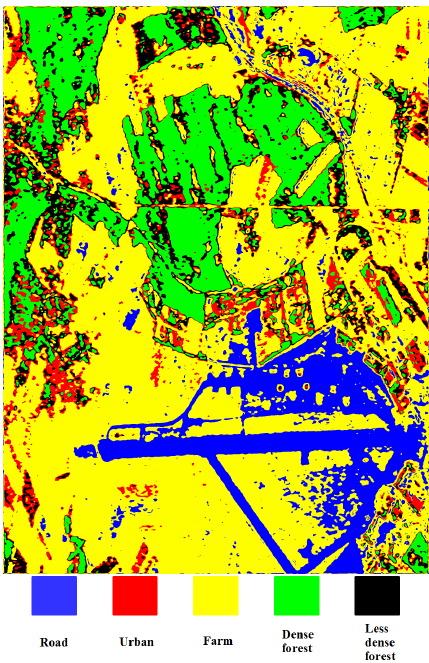
Figure 3. Improved Freeman-GMM classification